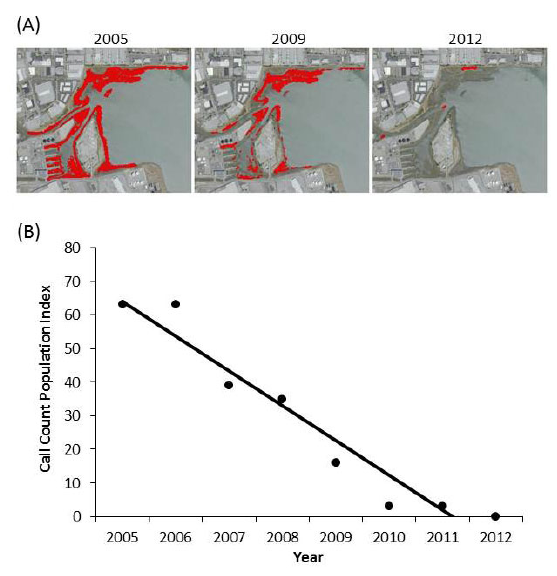
Fig. 3 . Extent of habitats dominated by invasive Spartina delineated from aerial photography (shown in red) before treatment in 2005, after initial treatments in 2009, and after near eradication in 2012 (A); and call-count survey detections and trend (−10.3 birds per year) within Colma Marsh (B).